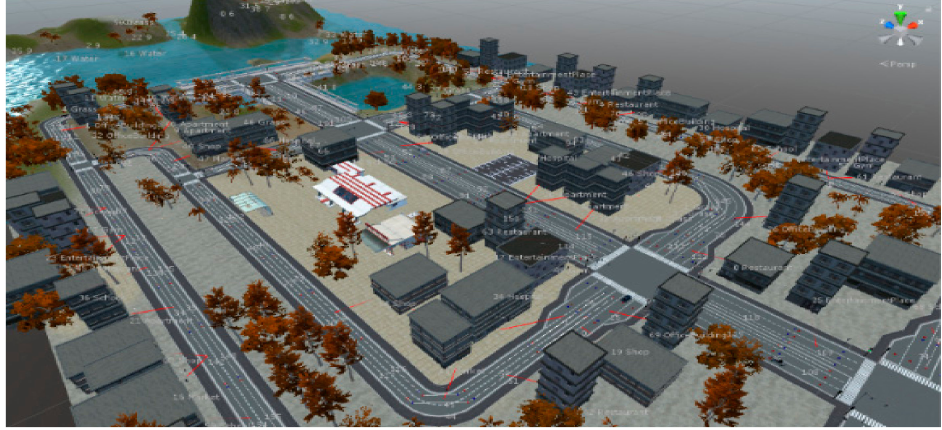
Figure 6. Virtual simulator environment for an autonomous vehicle to